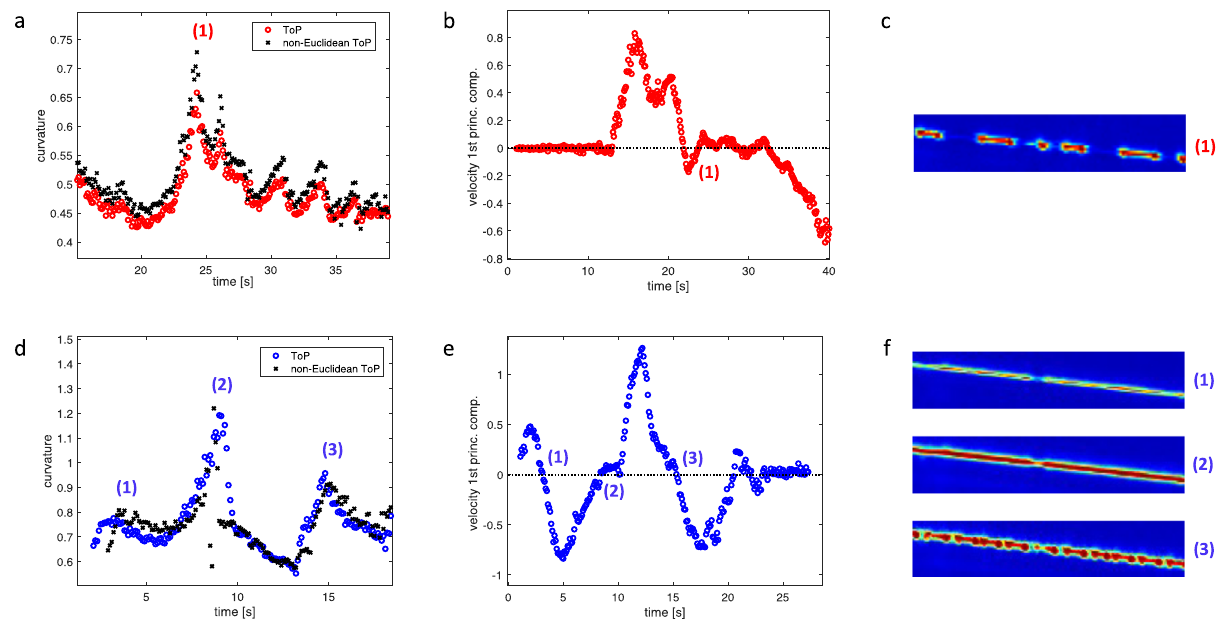
Fig. 6 The top and bottom rows represent the nematic-isotropic and isotropic-nematic transitions, respectively, for the 6 μ m capillary. a, d The curvature of the topological pathways, while ( b, e ) are their velocities plots. The Euclidean topological pathways and non-Euclidean topological pathways are represented by the red circles and the black crosses respectively. c, f Zoomed-in images of the capillaries with colormap representing the light intensity, increasing from blue (total darkness) to red (maximum brightness). The maximum of curvature in ( a ), indicated by ( 1 ), corresponds to the transition point when the structural heterogeneity reaches its maximum and ( c ) the nematic domains begin to collapse. The three curvature maxima in ( d ) correspond to the same-numbered pictures in ( f) : ( 1 ) is the early start of nematic domain formation; ( 2 ) is their further development; ( 3 ) is the early start of the ordered nematic phase. These three stages of the dynamics are also illustrated schematically in Fig. 5b –